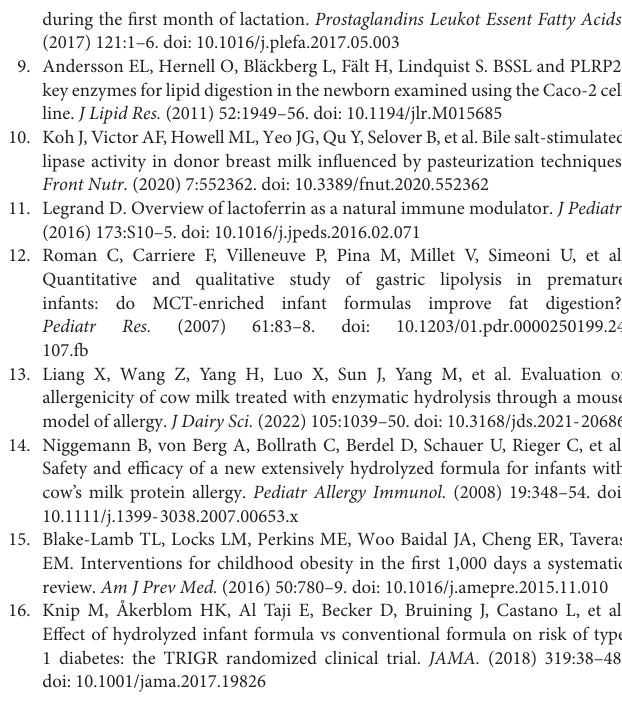
Supplementary Table 1 | Infant formula nutrition facts per 5 FL